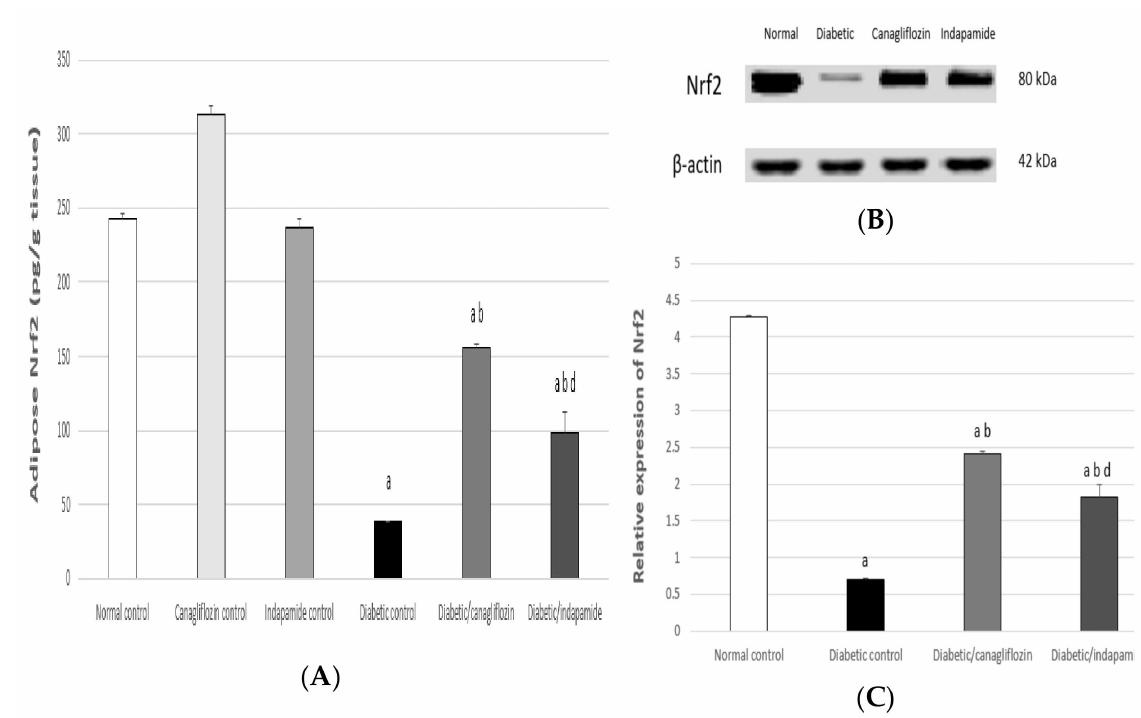
Figure 8. Impact of daily CANA and INDA treatment on epididymal adipose tissue Nrf2 content (ELISA) ( A ), (Western blotting) ( B , C ) oral CANA and INDA treatments were initiated once daily for 4 weeks. Data represent the mean ± S.E.M. (6 rats/group). ANOVA followed by post hoc Tukey–Kramer test at ( p < 0.05) was used for statistical comparison; a against normal CTRL, b